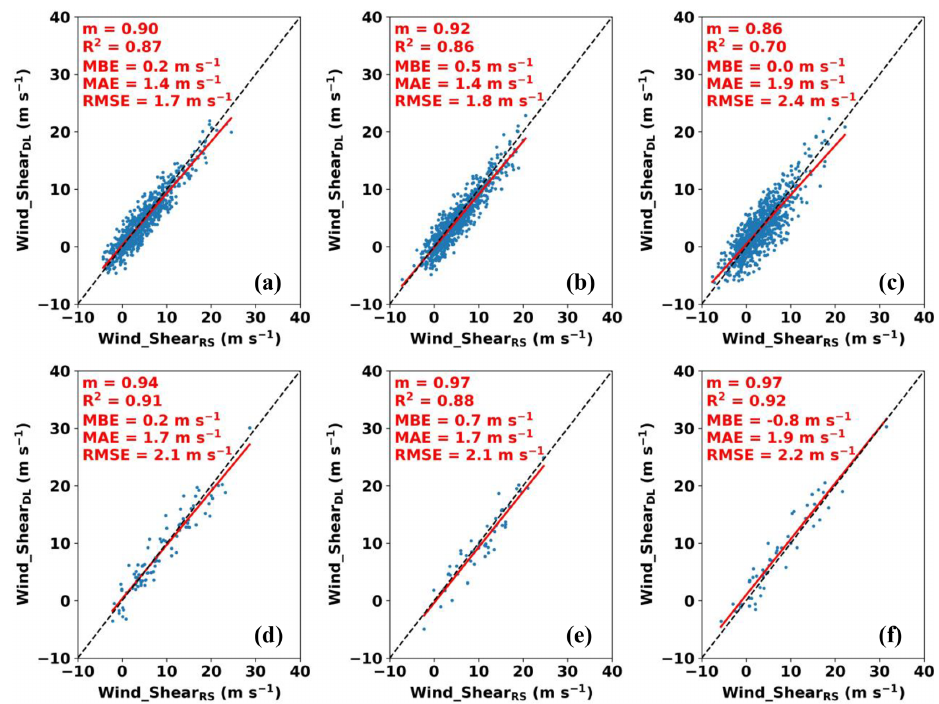
Figure 5. Scatterplots for RS- and DL-derived 100m–1km wind shear at three NYSM Profiler Network sites at (a) Buffalo, (b) Albany, and (c) Stony Brook and 100m–3km wind shear at (d) Buffalo, (e) Albany, and (f) Stony